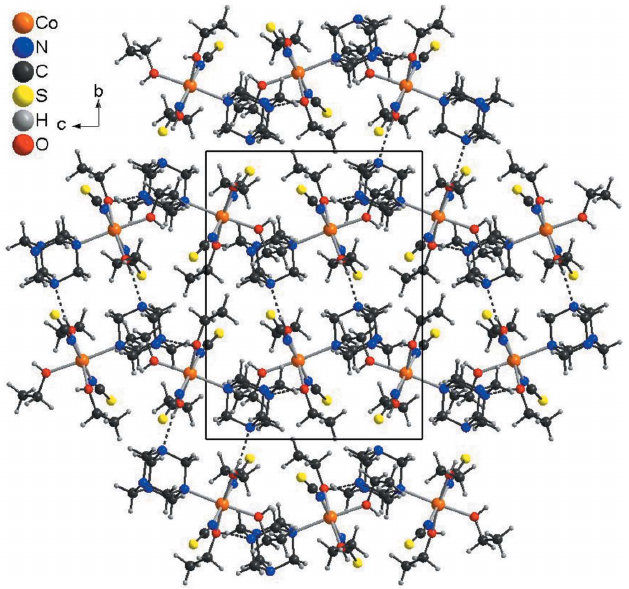
Figure 7 Crystal structure of compound 2 with a view along the crystallographic a axis and intermolecular O—H (cid:2)(cid:2)(cid:2) N hydrogen bonding shown as dashed lines.